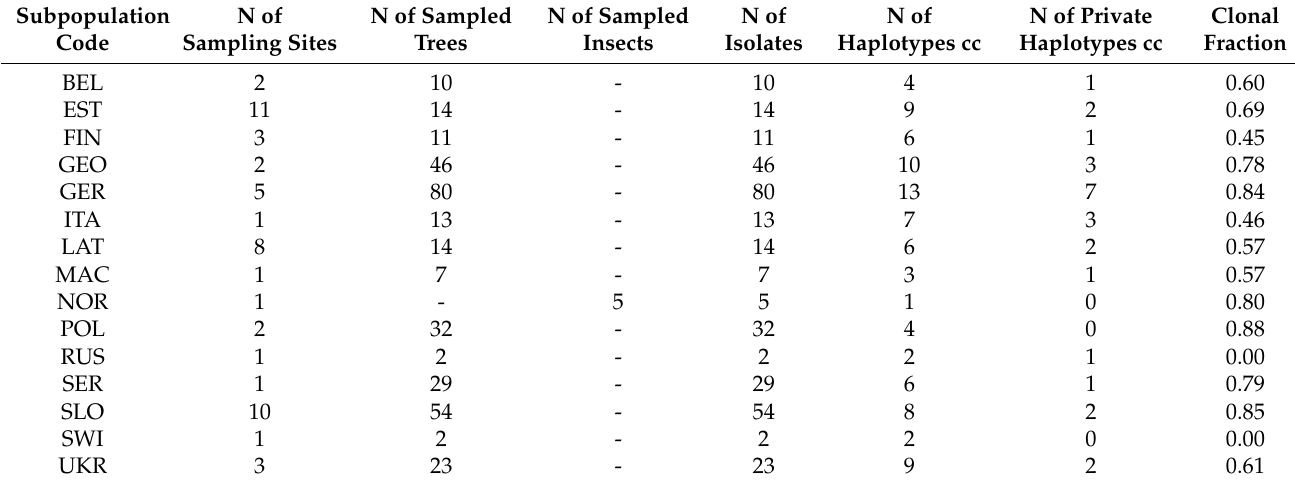
Table 3. Number of haplotypes found in the investigated subpopulations of D. sapinea and the clonal fraction among isolates of each subpopulation .